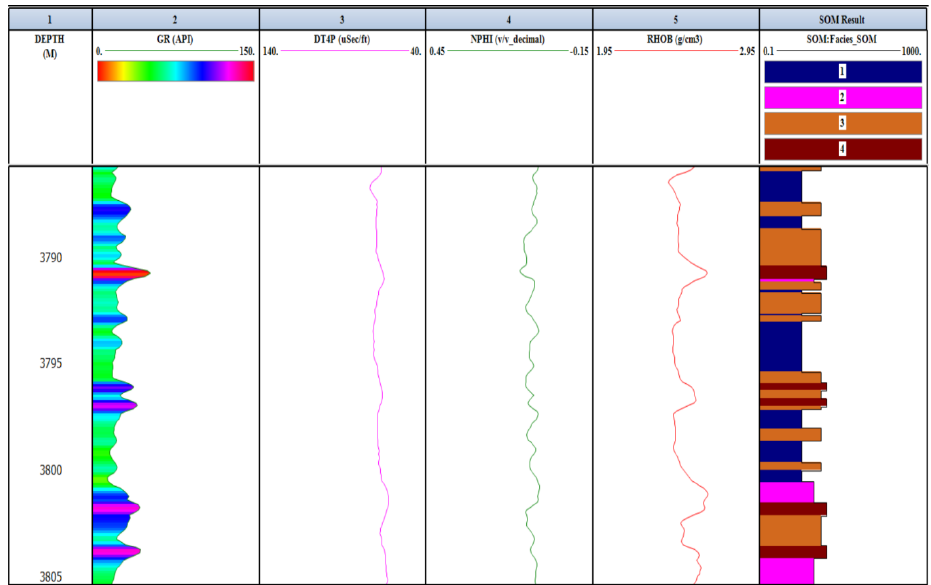
Figure 6. SOM vertical distribution model showing the interpreted lithofacies for the four input parameters after calibration. Table 1. The results of “cluster means” plus other statistics of user data for each cluster.